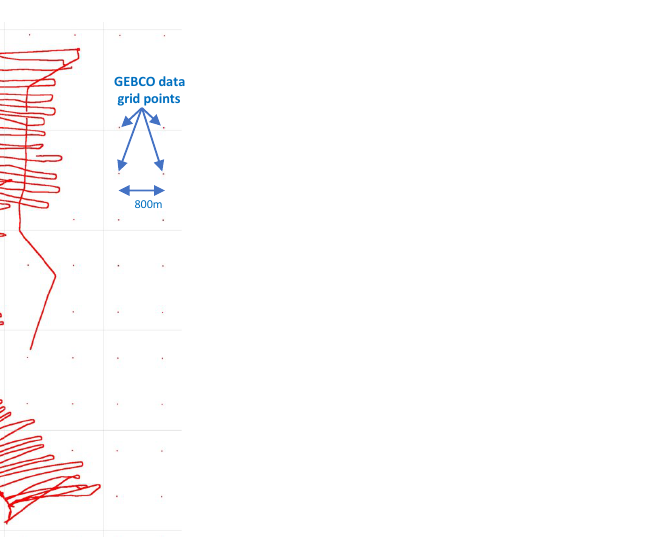
Figure 5. Bathymetry data input includes GEBCO data grid points and COASTVAR measured topography data points.